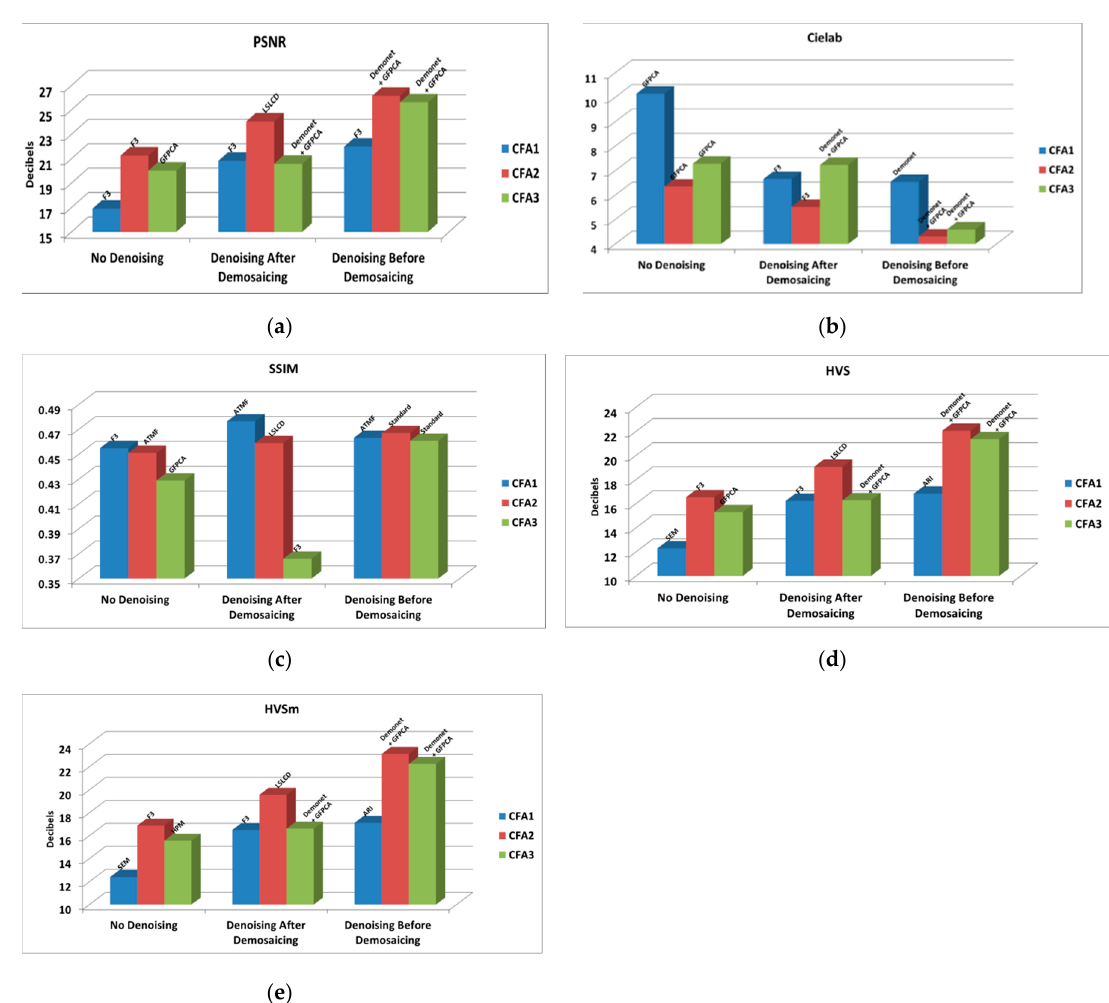
Figure 21. Best against the best comparison between CFAs 1.0, 2.0, and 3.0 with and without denoising at 10 dBs SNR. ( a ) PSNR metrics; ( b ) Cielab metrics; ( c ) SSIM metrics; ( d ) HVS metrics; ( e ) HVSm